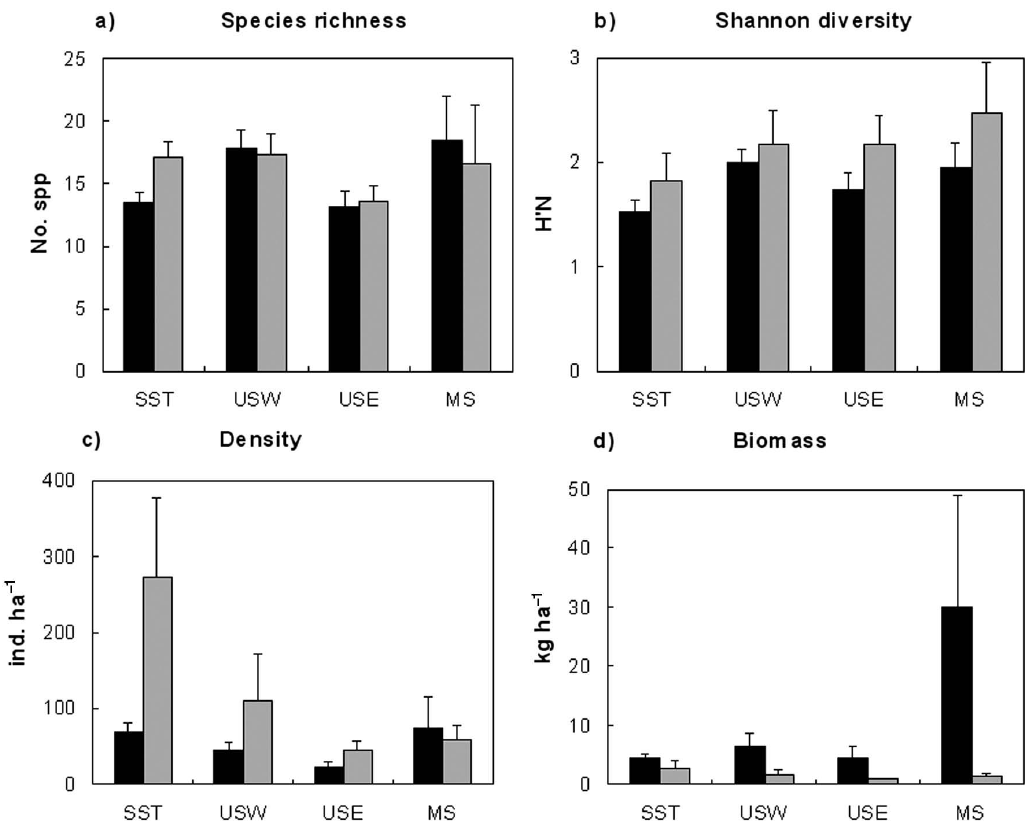
Fig . 4. – Differences in community indices between cluster groups for fish (black) and invertebrates (grey).